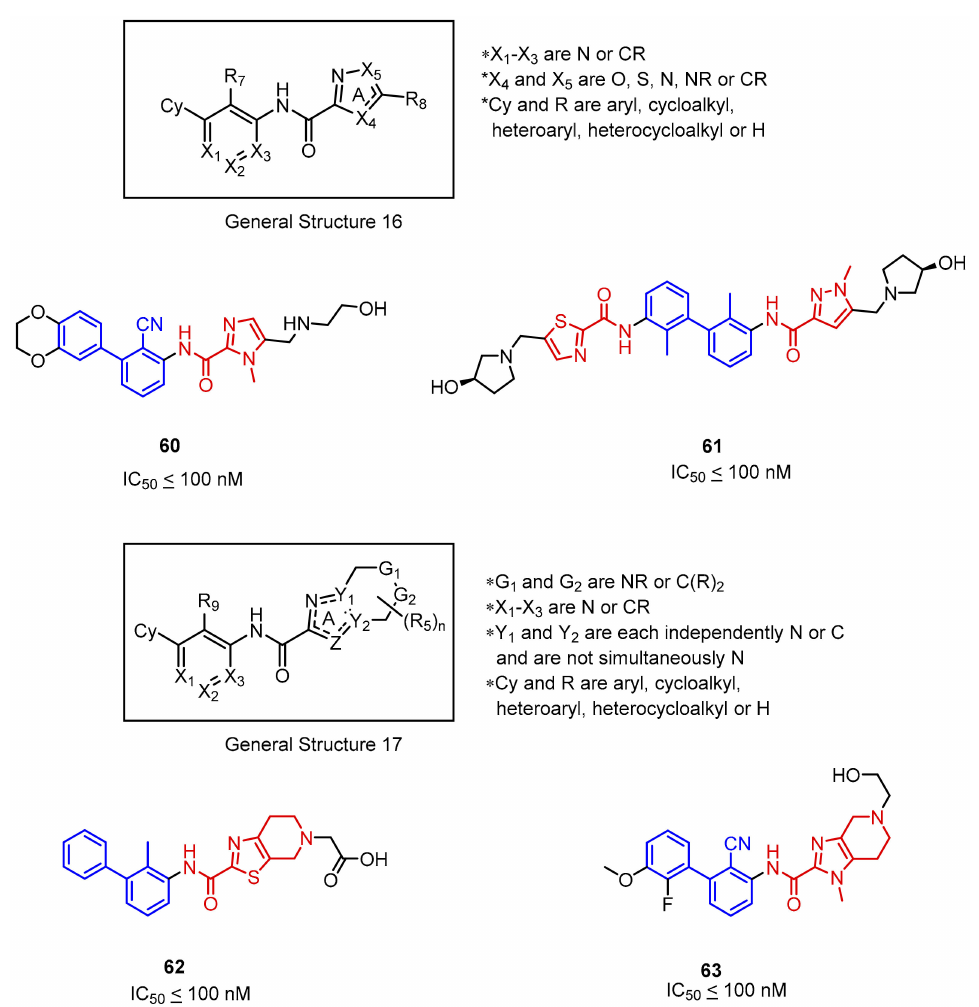
Figure26. GeneralstructuresandexamplesofthePD-1 / PD-L1inhibitorspatentedbyIncyteCorporation, based on heterocyclic five-membered aromatic rings ( 60 and 61 ) and on heterocyclic five-membered aromatic rings fused with piperidine ( 62 and 63